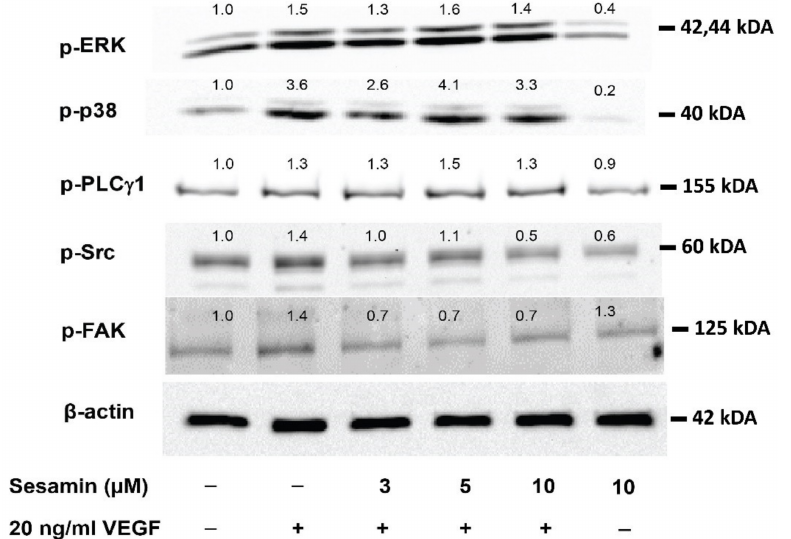
Figure 4. The effect of sesamin on the activation of intracellular signaling pathways induced by VEGFA in human endothelial cell line, EA.hy926. Following the pretreatment with sesamin (3–10 µ M) for 2 h, EA.hy926 cells were treated with 20 ng/mL VEGFA for 5 min to study the expression of phosphorylated ERK, p38, and PLC γ 1 or for 30 min to study that of phosphorylated Src and FAK. The expression levels of the phosphorylated forms were determined by western blot analysis using their specific antibodies. β actin was used as a loading control. Each sample was prepared for the detection of all signaling proteins together. The number above each band shows band density relative to its